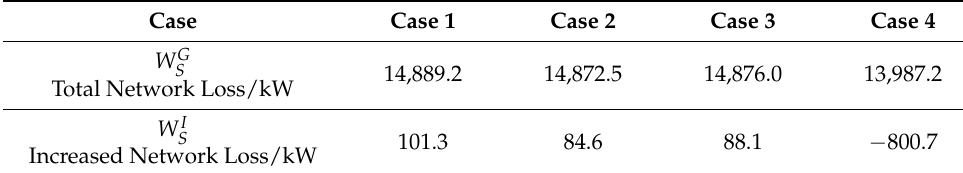
Figure 12. ( a ) Reactive power output by the DC/AC converter of OBMG in case 4; ( b ) reactive power output by the DC/AC converter of RMG in case 4. Table 4. Comparison of network loss in the four cases.